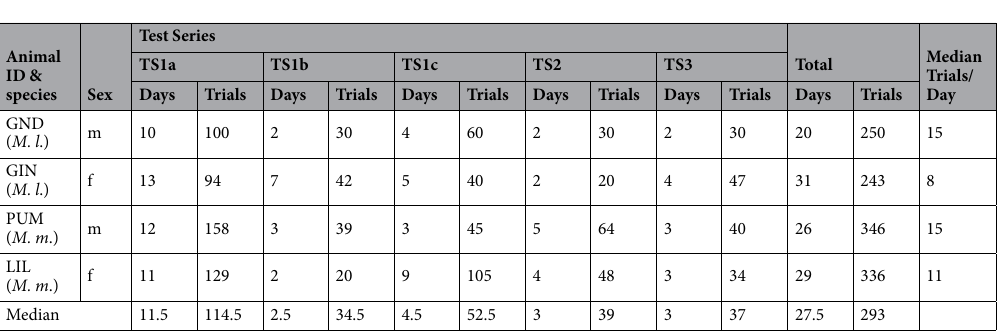
Table 1. Time needed for operant conditioning (without initial screening/pilot phase).